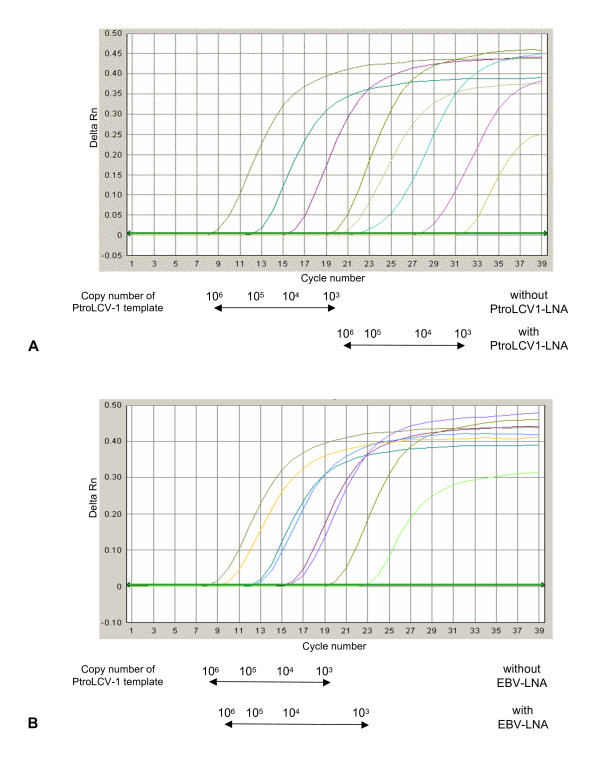
Real-time PCR of PtroLCV-1 DPOL in the presence or absence of LNA. Amplification curves are shown for pan-herpes DPOL PCR with a PtroLCV-1 DPOL amplimer (1 kbp) as template (103 – 106 copy numbers). Real-time PCR was carried out in the presence or absence of (A) LNA-PtroLCV1 or (B) LNA-EBV.